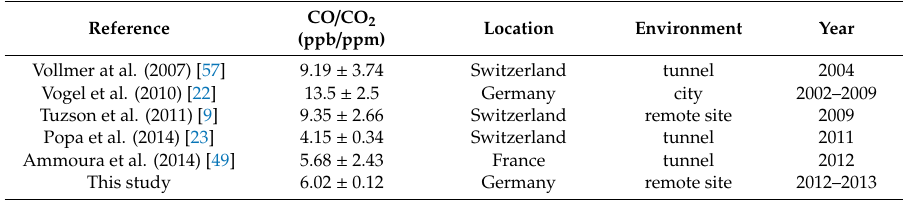
Table 3. CO / CO 2 emission ratios for tra ffi c and anthropogenic emissions in